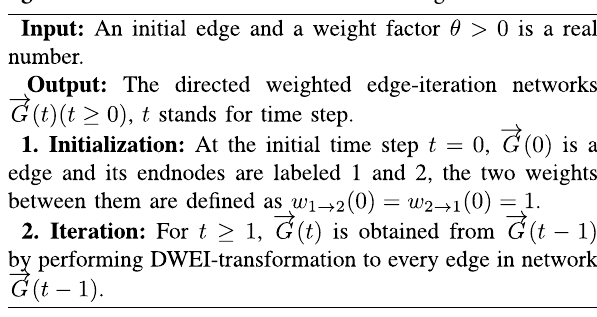
Algorithm 1. DWEI-network construction algorithm.